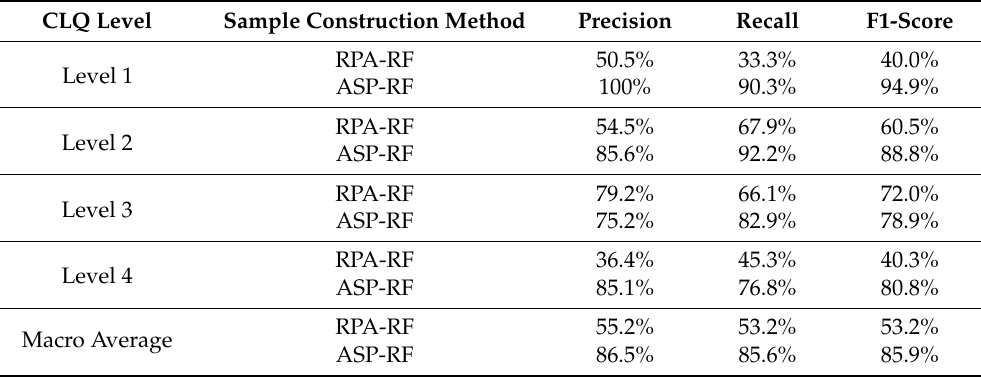
Table 4. Prediction accuracy data for the RPA-RF and ASP-RF models.